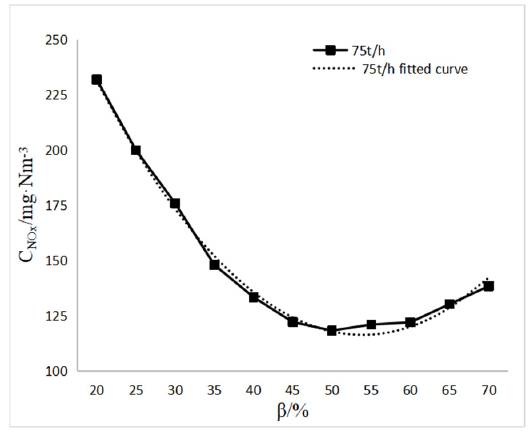
Figure 7. Influence of β on C NOx